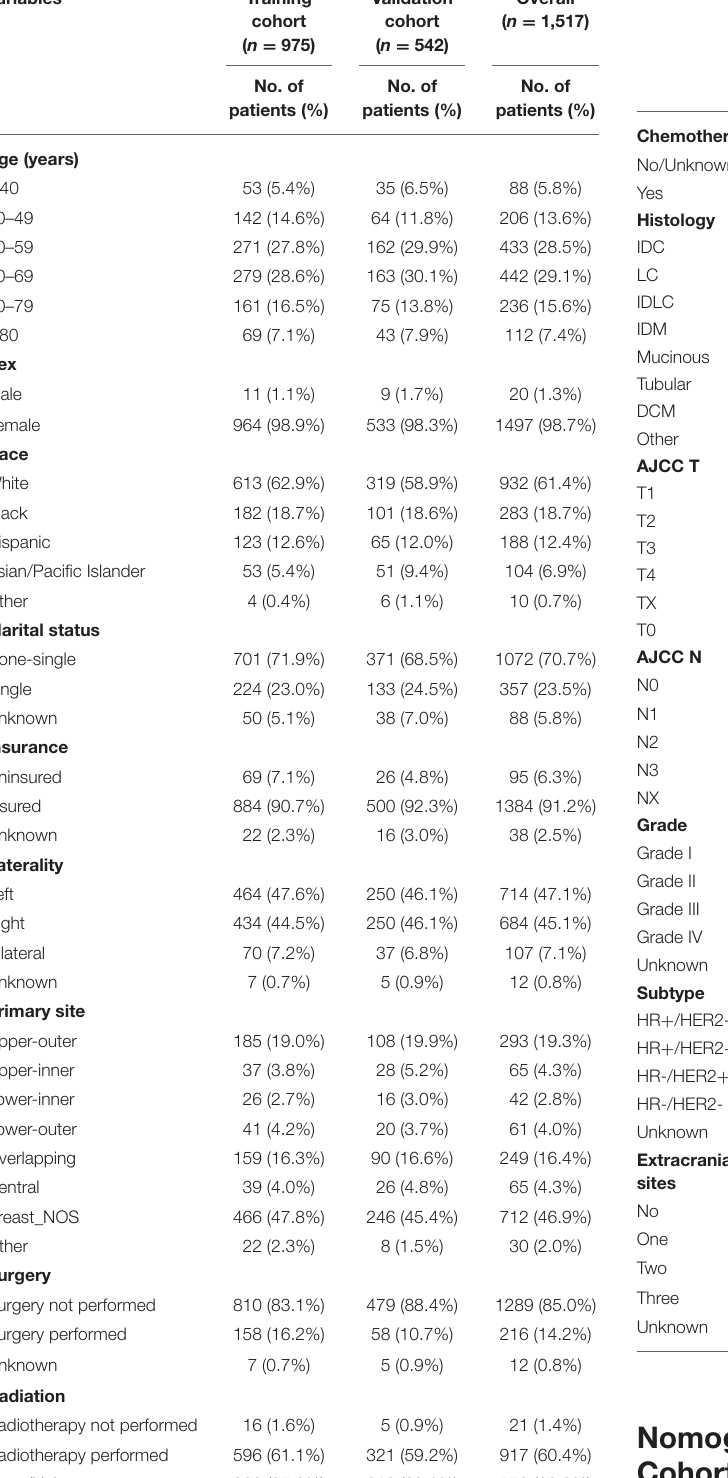
Supplementary Table 1 . Multivariate analyses